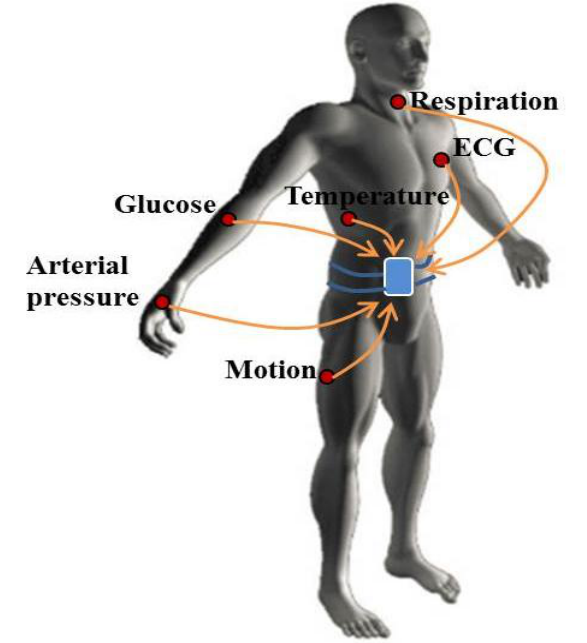
Figure 7. Typical WBANs for medical and health